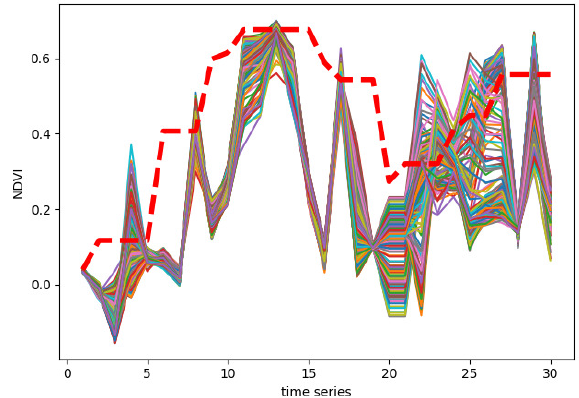
Figure 4. The continuous colored curves are the real NDVI of all the “winter wheat” class pixels available in a patch of size 48 × 48 pixels, in one year (30 samples). While the red dashed curve represents the average value computed by us. Note that the average value is always positive because we filtered the signal with a RELU